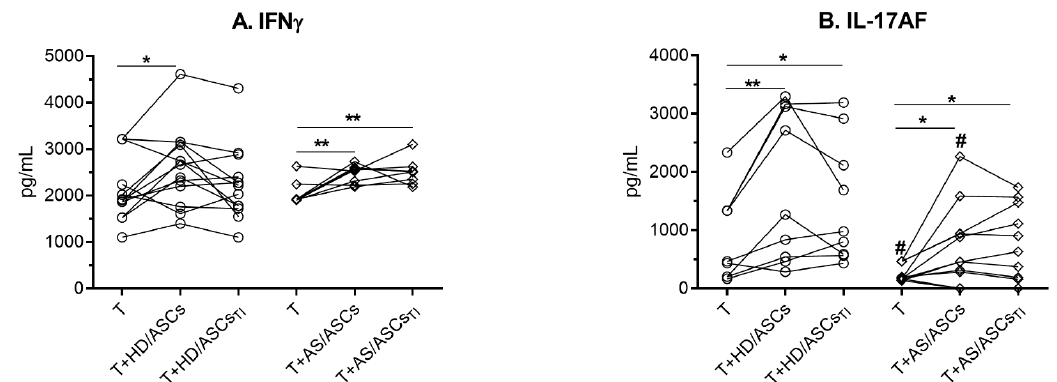
Figure 3. The effects of ASCs on the secretion of IFN γ ( A ) and IL-17AF ( B ). Cells were prepared and co-cultured as described in Figure 1. The concentrations of IFN γ and IL-17AF were measured in culture supernatants by specific ELISAs as described in the Material and methods. Lines between points identify cultures containing the same combination of ASCs and T cells. For intragroup comparisons (* p < 0.05; ** p < 0.001) data were analyzed by the one-way analysis of variance (ANOVA) with repeated measures and post-hoc Tukey test, while Mann – Whitney test (# p < 0.05) was used for inter-group comparison.